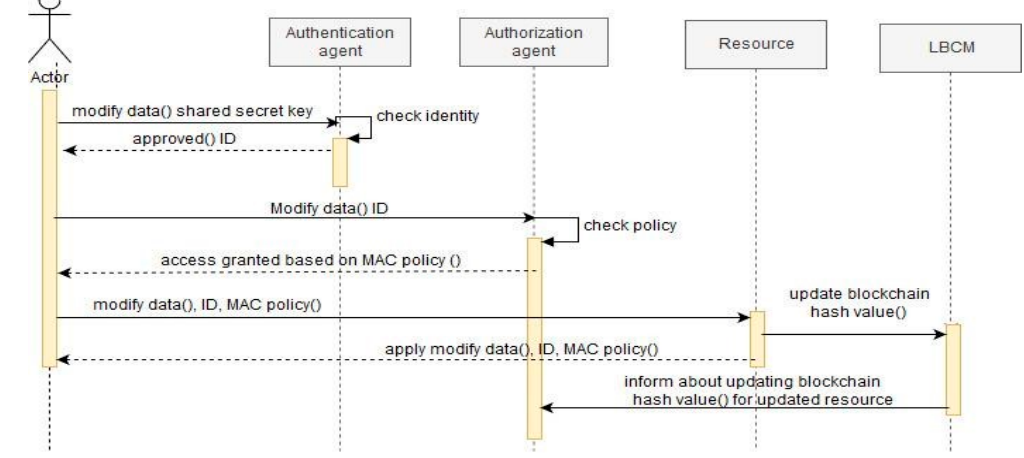
Figure 5. Sequence diagram for Authentication and Authorization